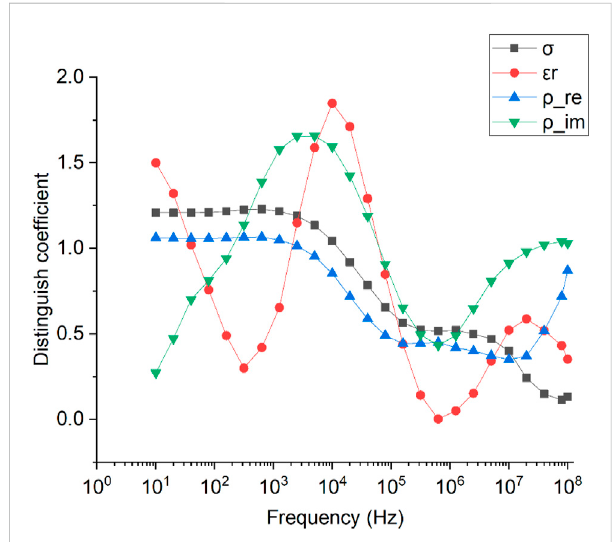
fi city ranged from 0.823 to 1 and from 0.735 to 0.964,